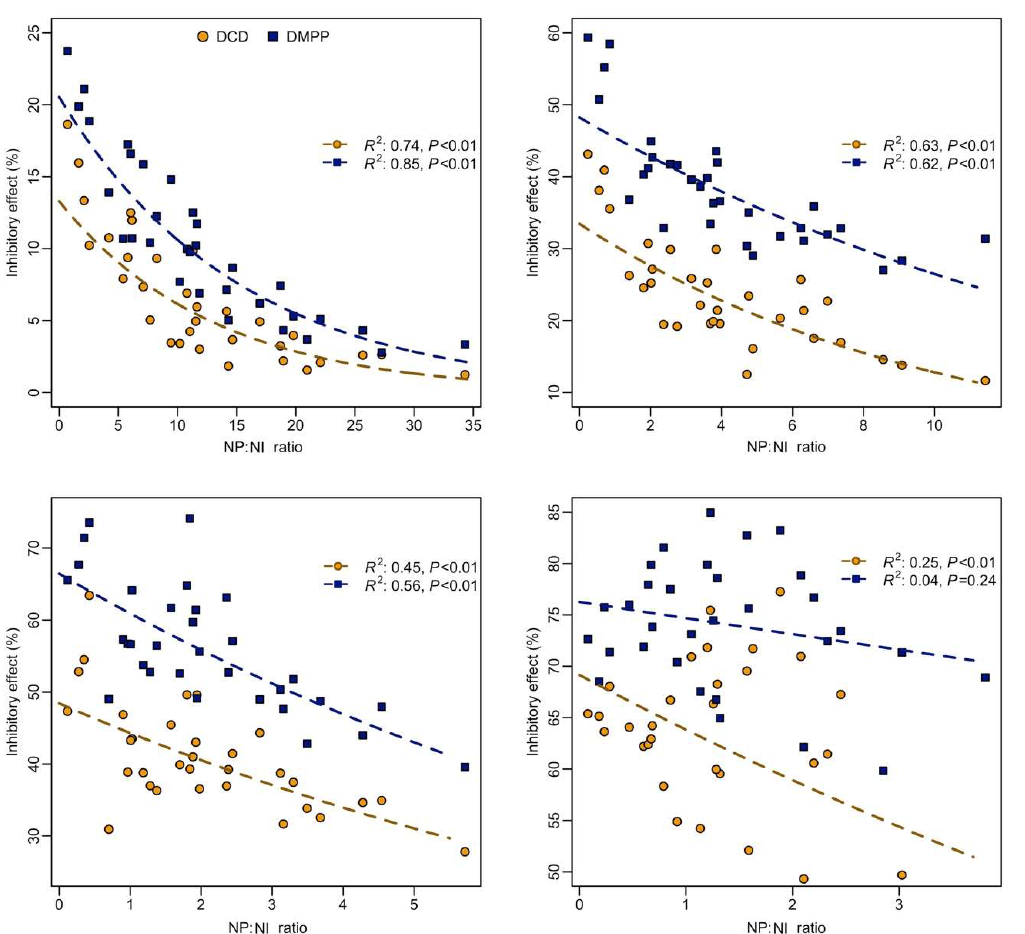
Figure 3. Influence of the different nitrification potential to NI application rates (NP-to-NI) ratios on inhibitory effect (%) of DCD and DMPP.